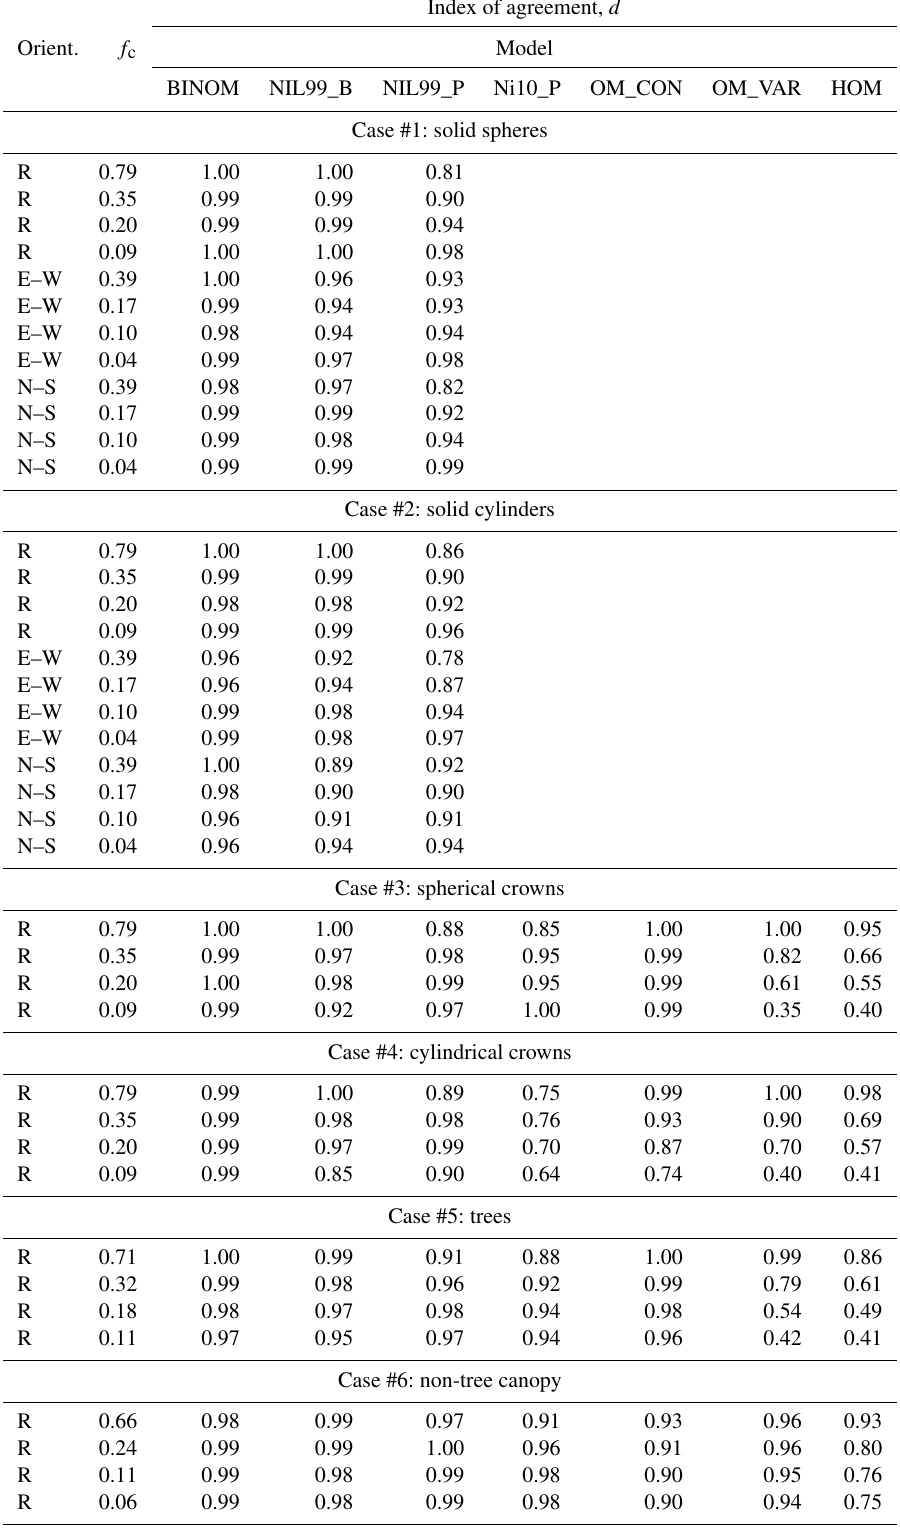
Table 3. Summary of test case results. Agreement between the four models of radiation interception is compared against the exact interception using the index of agreement (Eq.